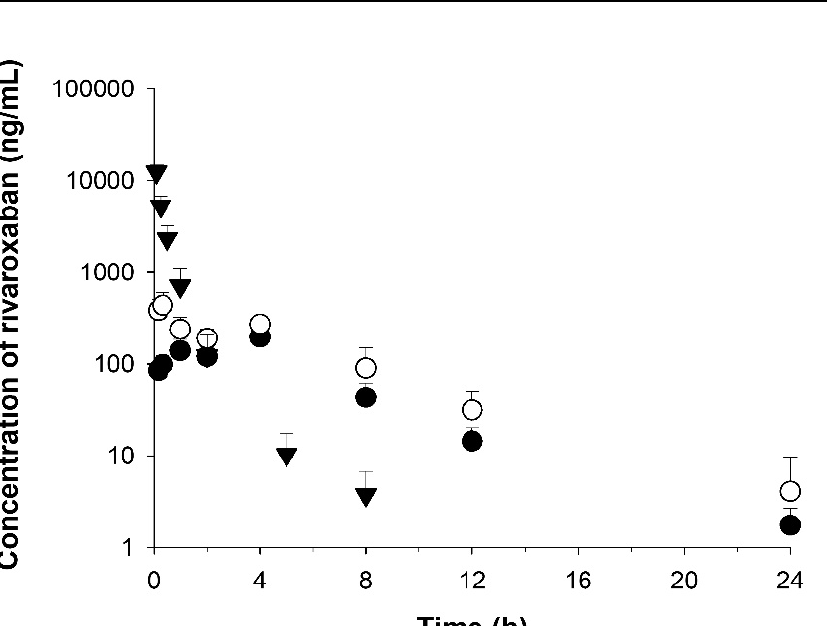
Figure 11. Temporal profiles of RXB concentrations in rat plasma after oral administration of opti- mized RXB-ASD ( ○ ) and RXB powder ( ● ) at a dose of 10 mg/kg and after intravenous admin- istration of RXB powder ( ▼ ). Data are shown as the mean ± SD ( n = 4). Based on a pharmacokinetic study in rats, the results show that hot-melt extruded ASD containing RXB with combinations of polymers increased the absorption and bioavailability by improving the solubility in an in vivo animal